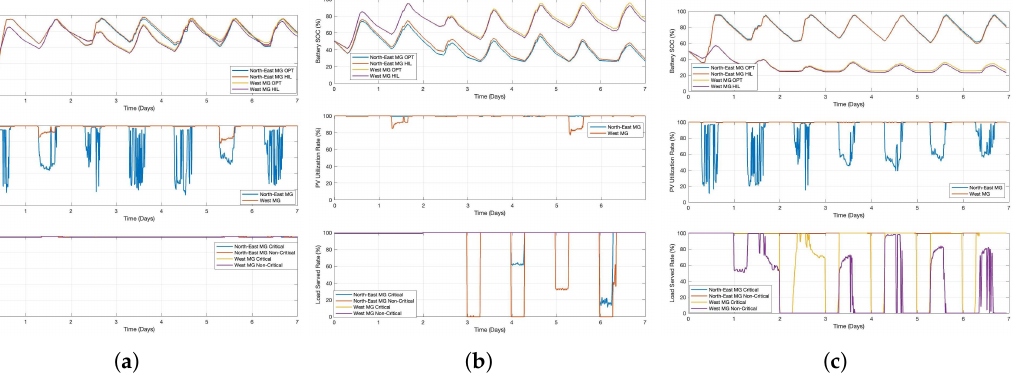
Figure 20. HIL testing results of the Adjuntas 2-microgrid system in independent operation cases. ( a ) Case 4. ( b ) Case 5. ( c ) Case